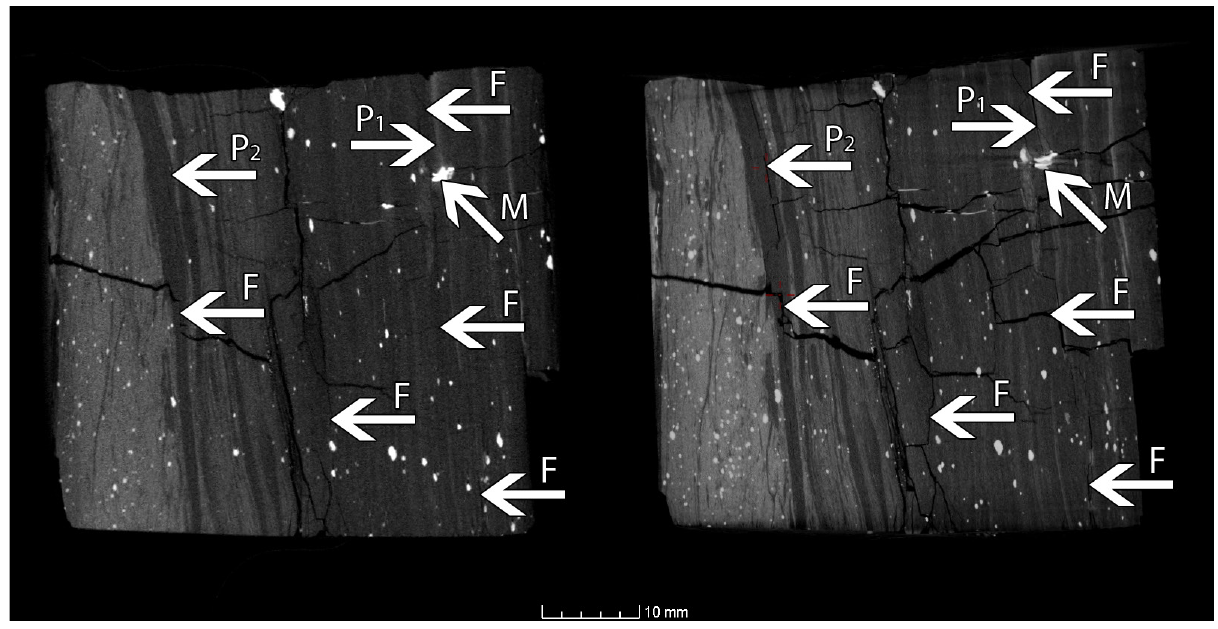
F indicates cleats or cracks that existed in the pre-loaded particles that enlarged during compression; P indicates either maceral–maceral boundaries or maceral–mineral boundaries that may have had an influence on crack initiation. Figure 7: Comparison of a particle before (left) and after (right) impaction with the bedding plane perpendicular to the